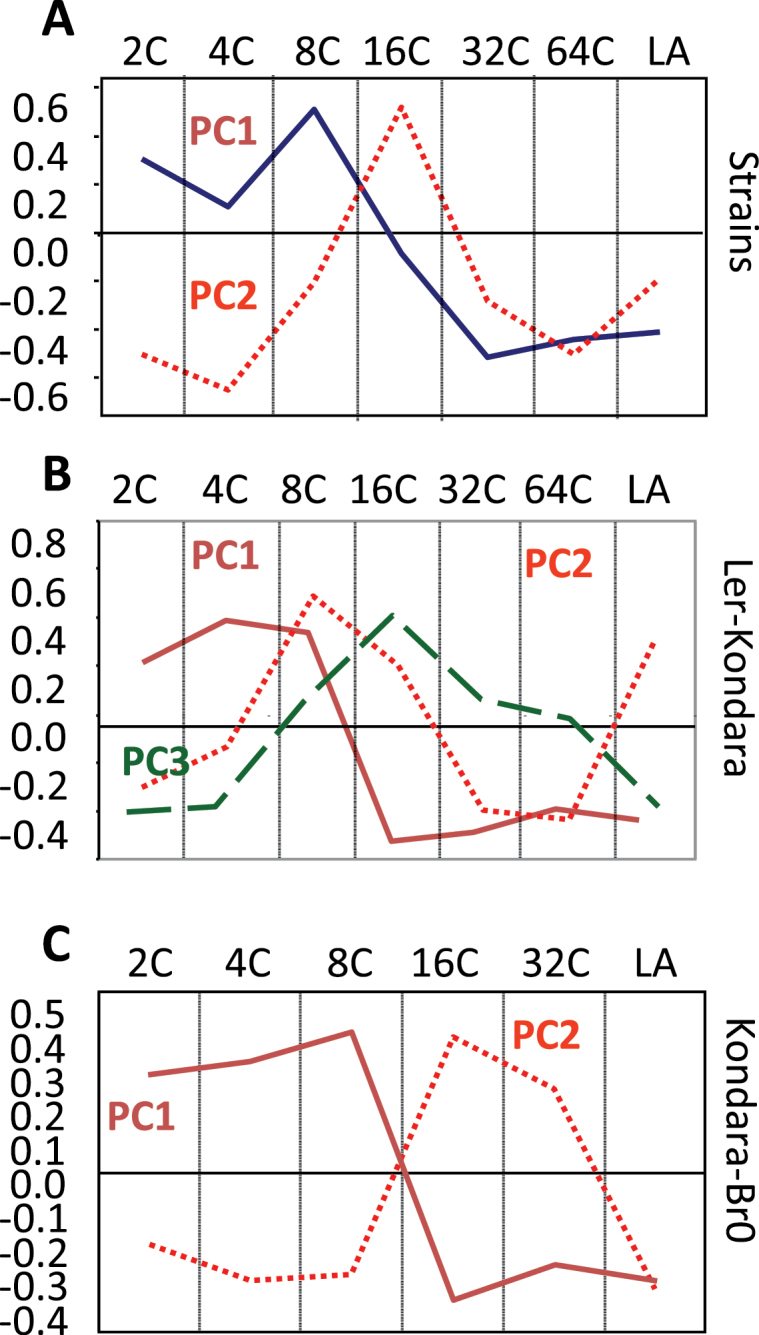
Phenotypic model for variation in endopolyploidy and leaf area in Arabidopsis accessions is analogous to that of the two mapping populations. Probability loadings for the principal components extracted for the Arabidopsis accessions (A) and the Ler-Kondara (B) and Kondara-Br-0 (C) RIL populations: blue solid line, PC1; red dotted line, PC2; green dashed line, PC3 (see also Supplementary Table S2 available at JXB online).